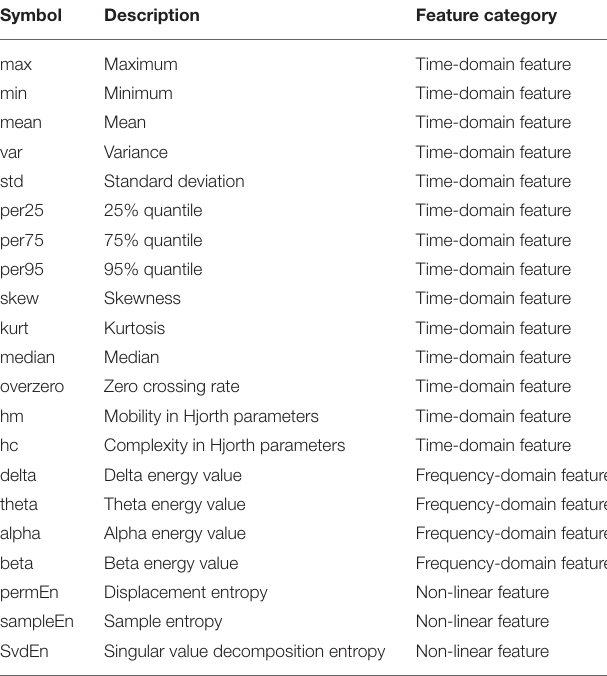
TABLE 1 | Extracted